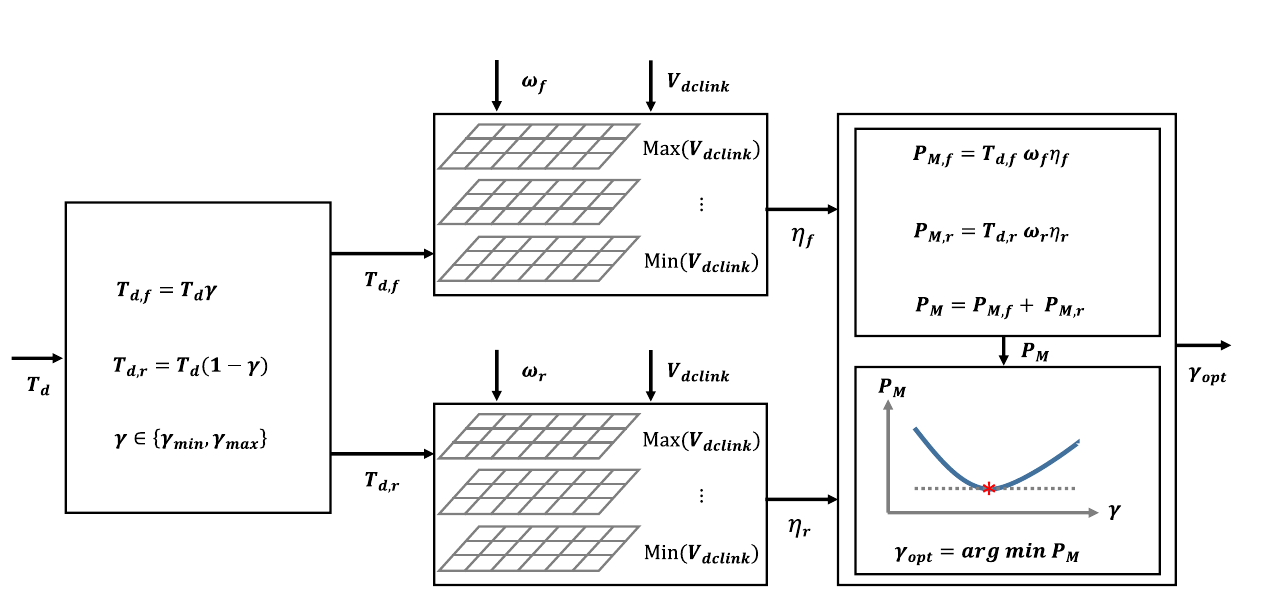
Figure 10. Concept of energy optimization.